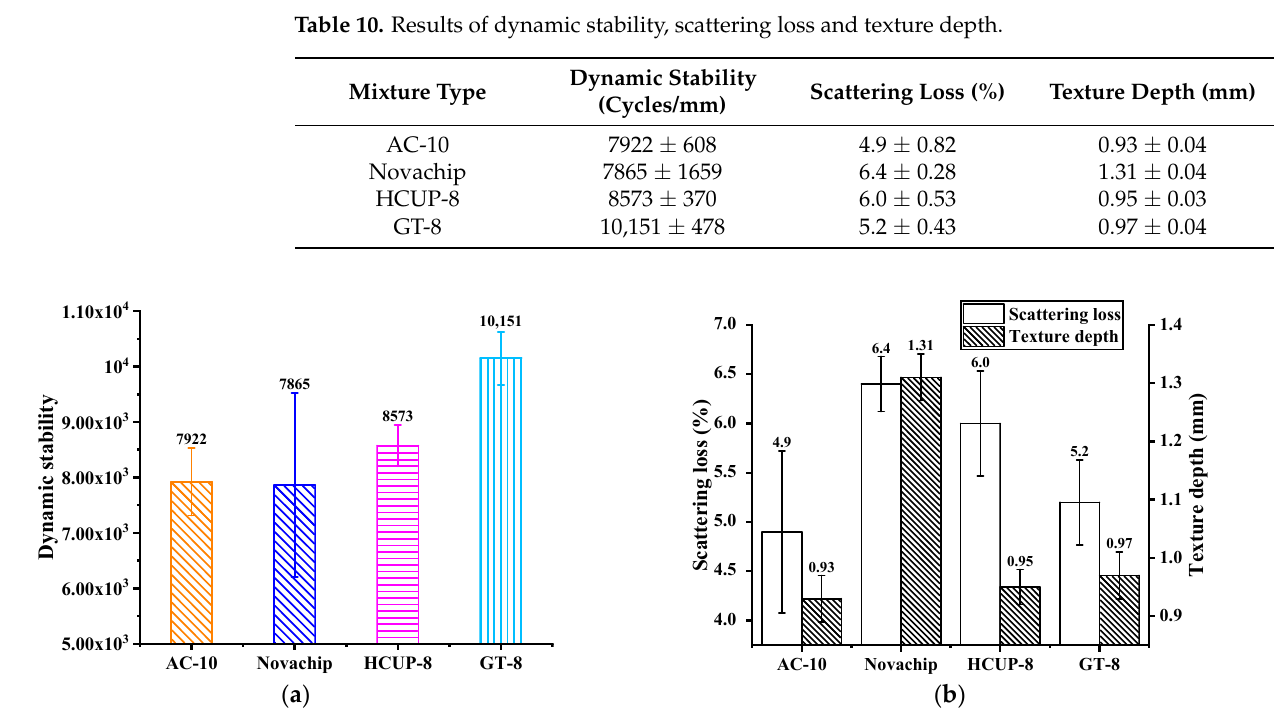
Figure 5. ( a ) Dynamic stability test; ( b ) scattering loss test and texture depth test. Table 10. Results of dynamic stability, scattering loss and texture depth.